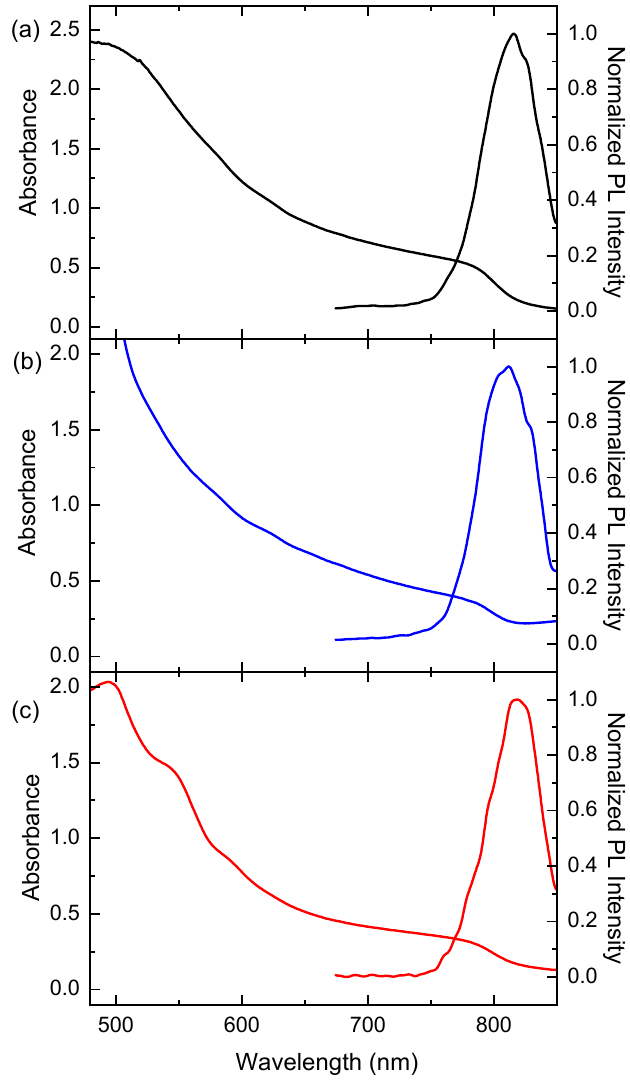
Figure 5. Absorption and PL spectra of the thin film perovskite FAPbI 3 prepared by a two-step sequential deposition method using various solvents for FAI: ( a ) IPA, ( b ) n -BuOH and ( c ) t-